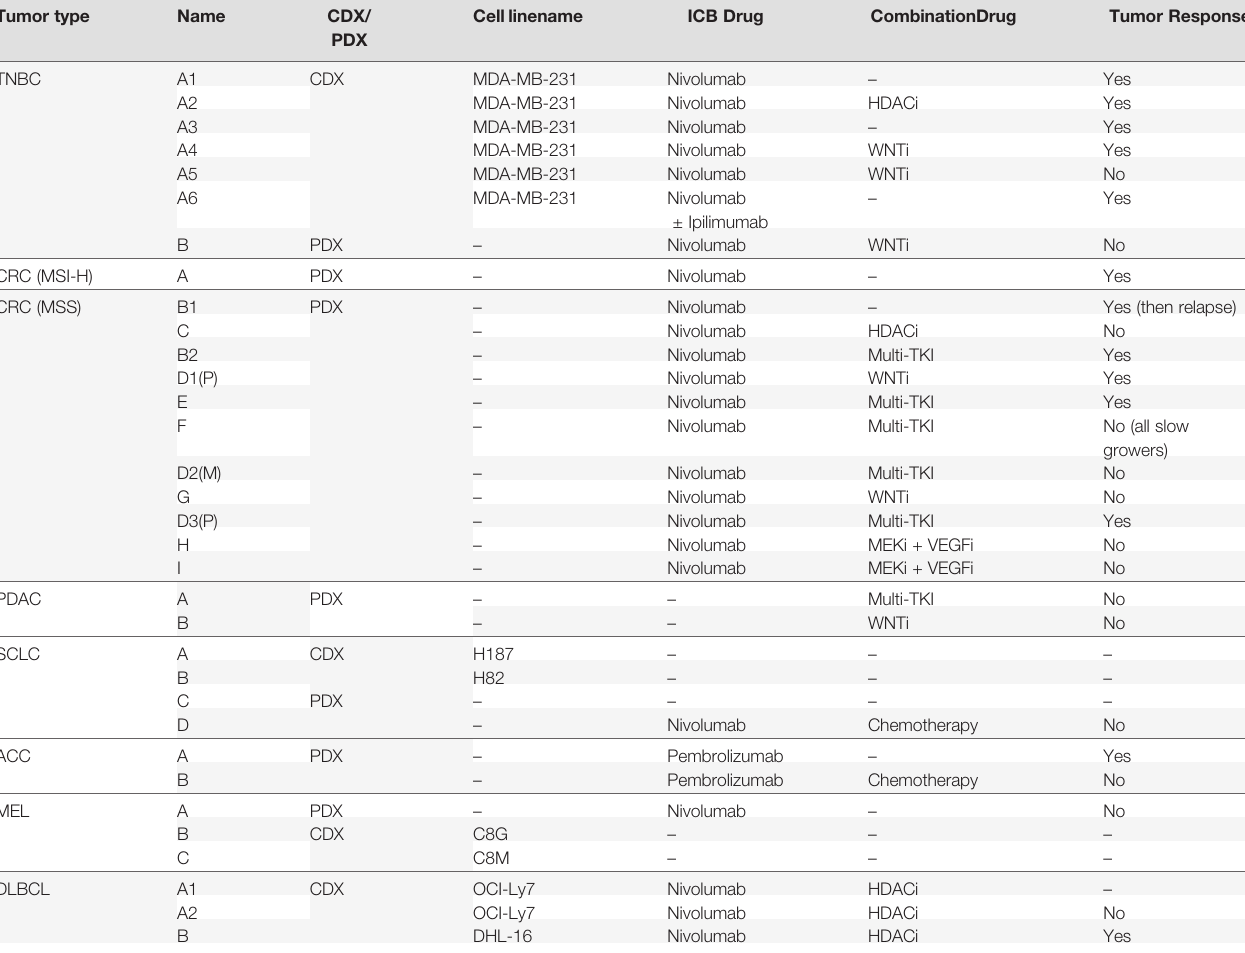
TABLE 3 | Human tumor xenografts and treatments in the HIS-BRGS